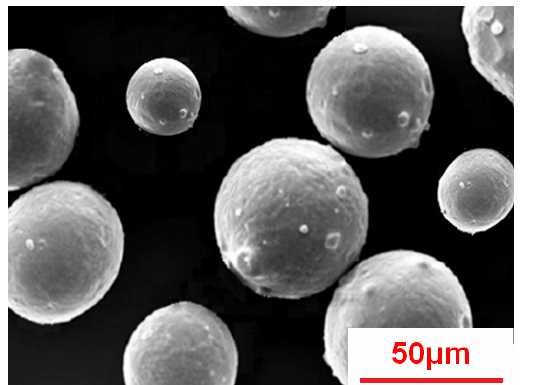
Figure 1 – (SEM) Scanning electron micrography of Ni22Cr10Al1Y powder particles Рис . 1 – (SEM) Электронная микрография частиц порошка